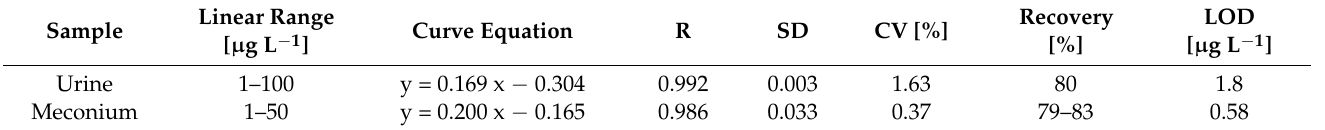
Table 2. Validation parameters of the IC-PAD method for the determination of the cyanide ion.